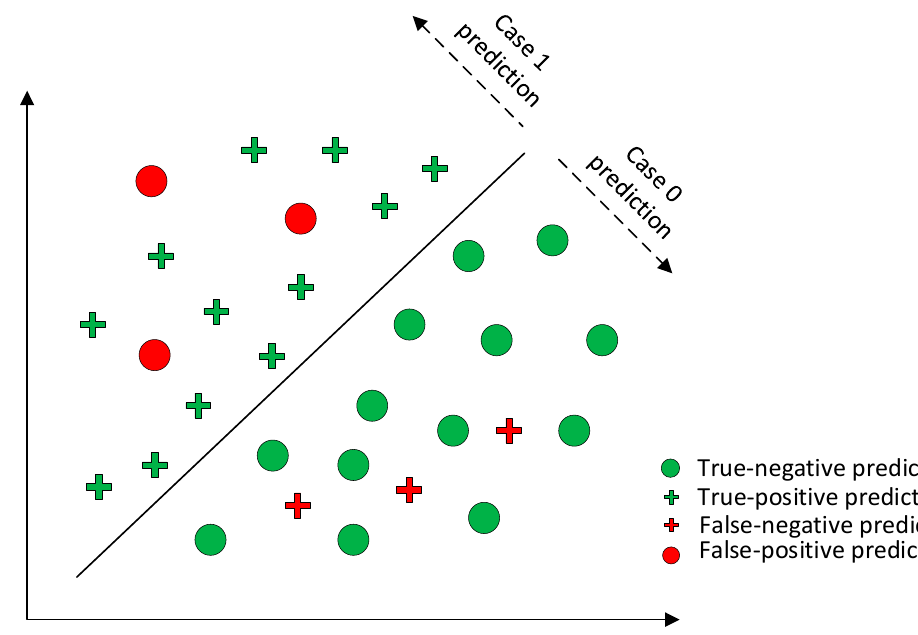
Figure 5. Visualization of the definition of the Precision and Recall.